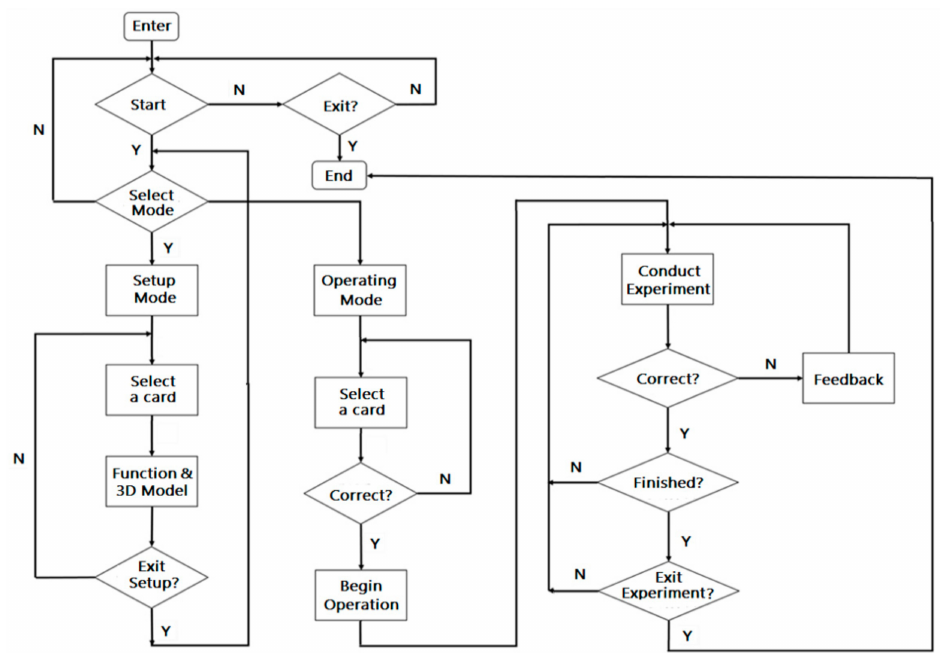
Figure 9. Operational flowchart of the virtual experiment.